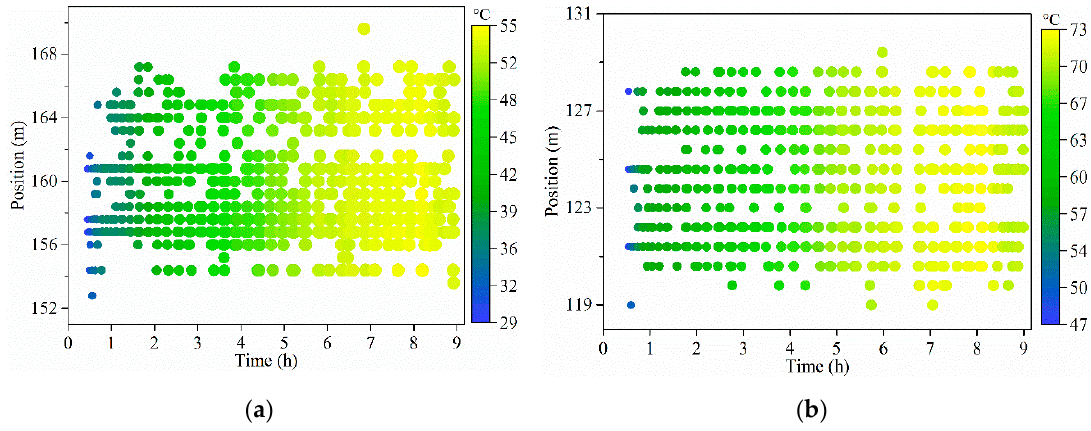
Figure 12. Hotspots distribution in phase A of ( a ) HV windings, and ( b ) LV windings.